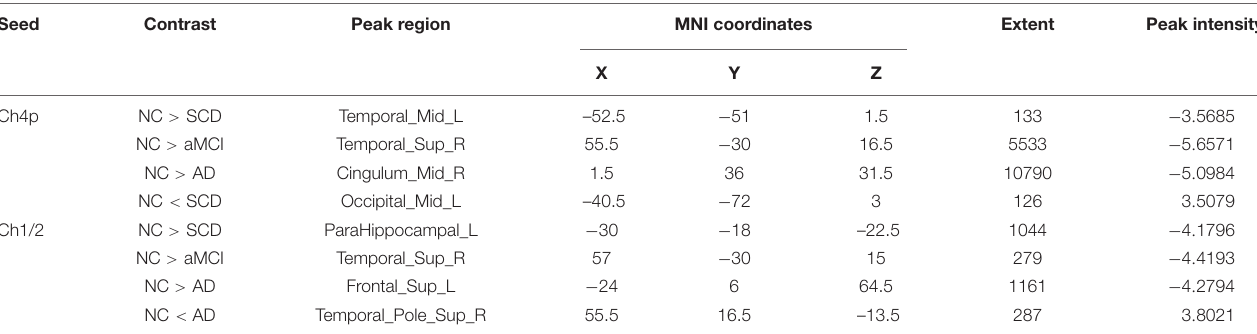
TABLE 4 | Significant between-group (NC-SCD, NC-aMCI, and NC-AD) differences in structural covariance networks seeding from the Ch4p and Ch1/2. Seed